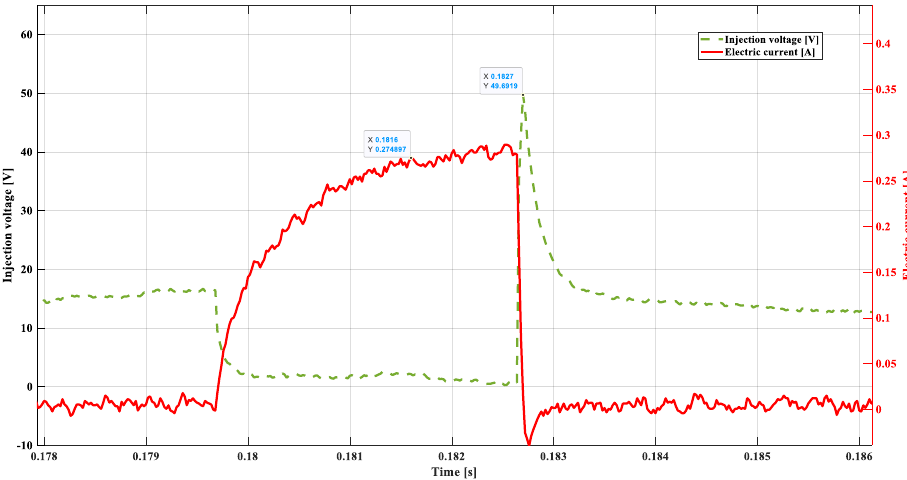
Figure 13. Including the resistance of 20 Ω, 800